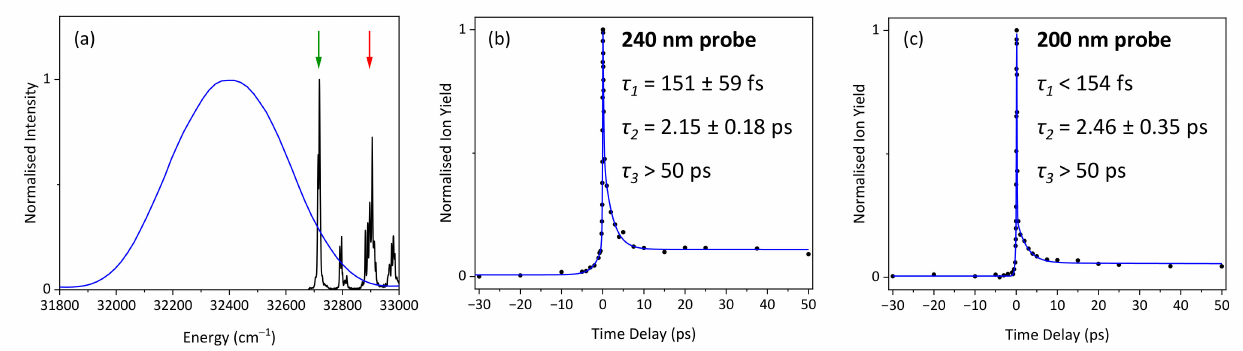
Figure 3. ( a ) Resonance enhanced multiphoton ionisation spectrum of p -HMC, relative to the S 1 ( ππ *) state, provided by Tan et al. [26]. The green arrow indicates the s- cis conformer and the red arrow indicates the s- trans conformer. Overlaid is the 308.5 nm (32,415 cm − 1 ) pump laser spectral profile which is used to selectively excite (predominantly) s- cis p -HMC to the S 1 ( ππ *) state. ( b ) Time-resolved ion-yield (TR-IY) transient of p -HMC at 308.5 nm pump and 240 nm probe with a 3 bar helium backing pressure. ( c ) TR-IY transient of p -HMC at 308.5 nm pump and 200 nm probe with a 1.5 bar helium backing pressure to reduce cluster formation (discussed infra ). In ( b , c ), the polarisations of the pump and probe beams were parallel with respect to each other, and the negative dynamics were zeroed as the baseline fluctuated around zero due to poor background